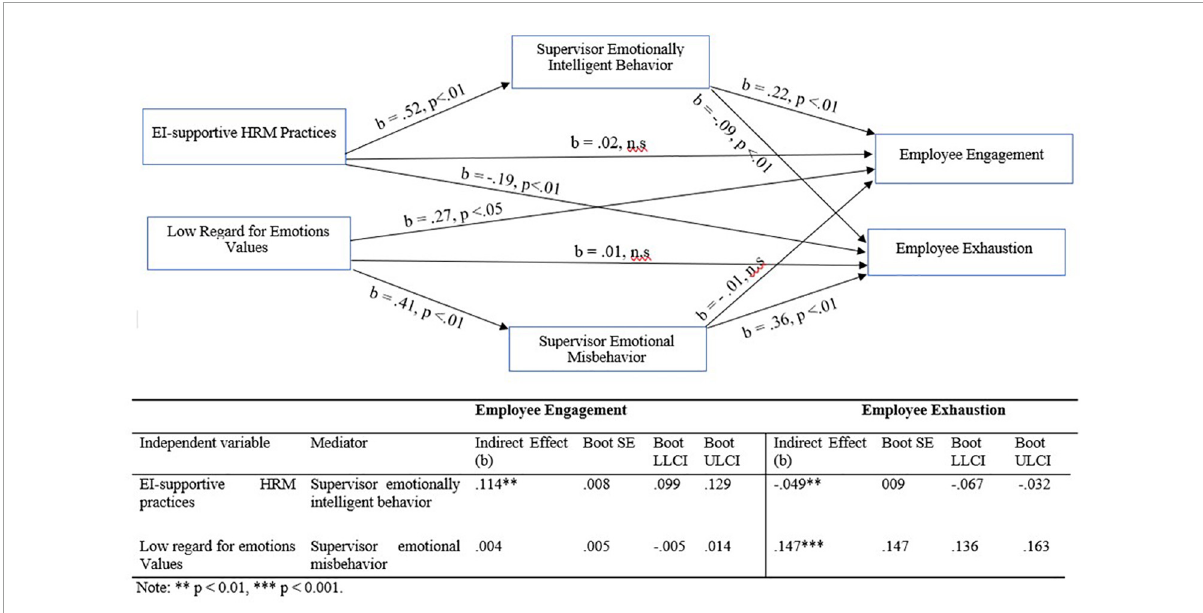
FIGURE2 Mediation effects of supervisor emotionally intelligent behavior and supervisor emotional misbehavior on the relationship of EI-supportive HRM practices and low regard for emotions values with employee engagement and